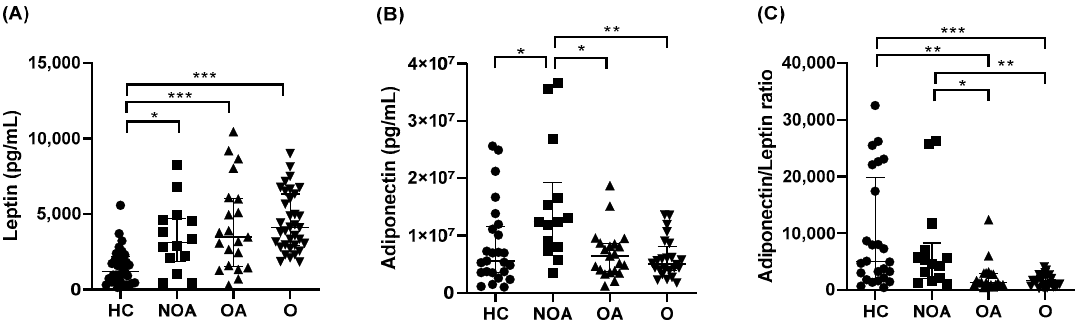
Figure 1. Leptin ( A ), adiponectin ( B ), and adiponectin/leptin ratio ( C ) serum level comparisons between groups. Data presented as individual values and as medians (25th–75th percentile). HC, healthy controls; NOA, non-obese asthmatics; OA, obese asthmatics; O, obese subjects. * p < 0.05, ** p ≤ 0.01, *** p ≤ 0.001; Kruskal–Wallis followed by Dunn’s multiple comparisons test.